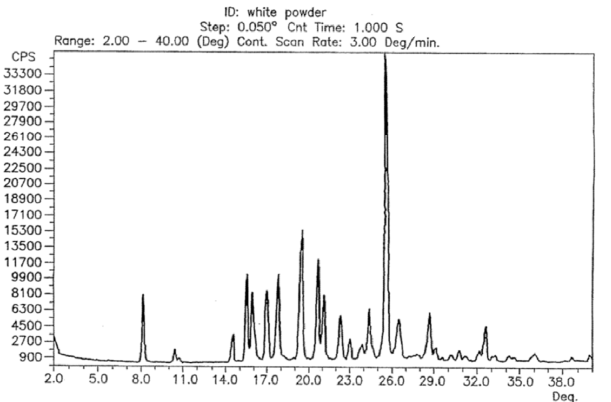
Figure 3. Powder X-ray pattern of form I as reported by Dolitzky et al. [18]. Permission obtained from Prof. Dr O. Reany.